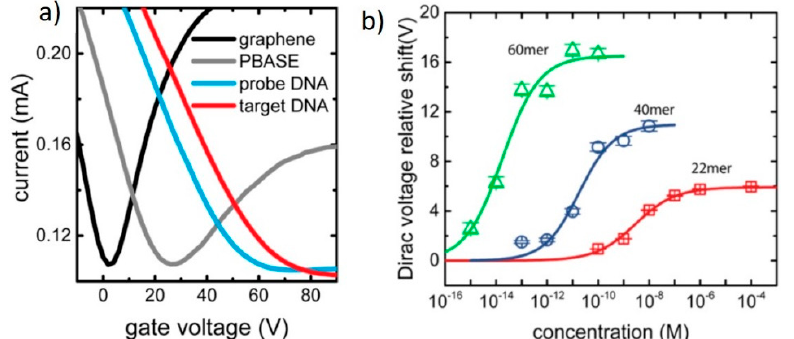
Figure 3. ( a ) I-V g characteristics of a G-FET proposed by Ping et al., highlighting the change in electronic characteristics at each stage of the functionalization and detection process. ( b ) Dirac voltage shift of increasing concentrations of DNA oligomers of different lengths fitted using the Sips model. Adapted from [25]. Copyright 2016 by the American Chemical Society.